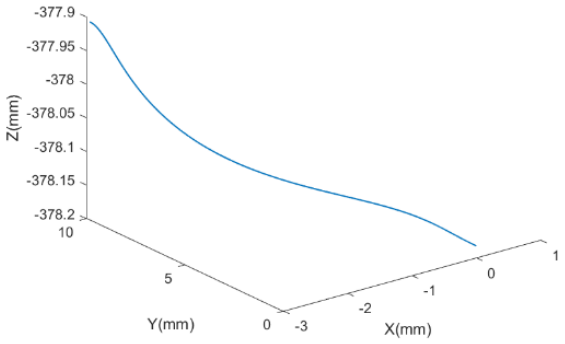
Figure 10. The torque of the unbalanced and optimized SPR at ( a ) “low” and ( b ) “high” for trajectory 1.